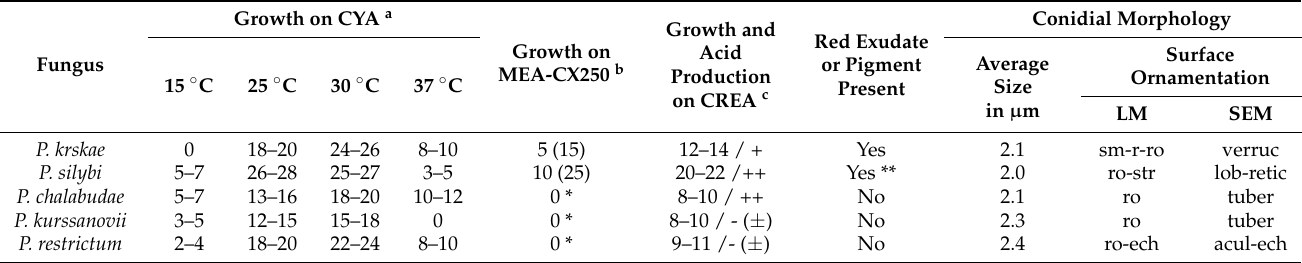
Table 2. Comparison of the main distinctive phenotypic characteristics of phylogenetically related Penicillium spp. in series Restricta .